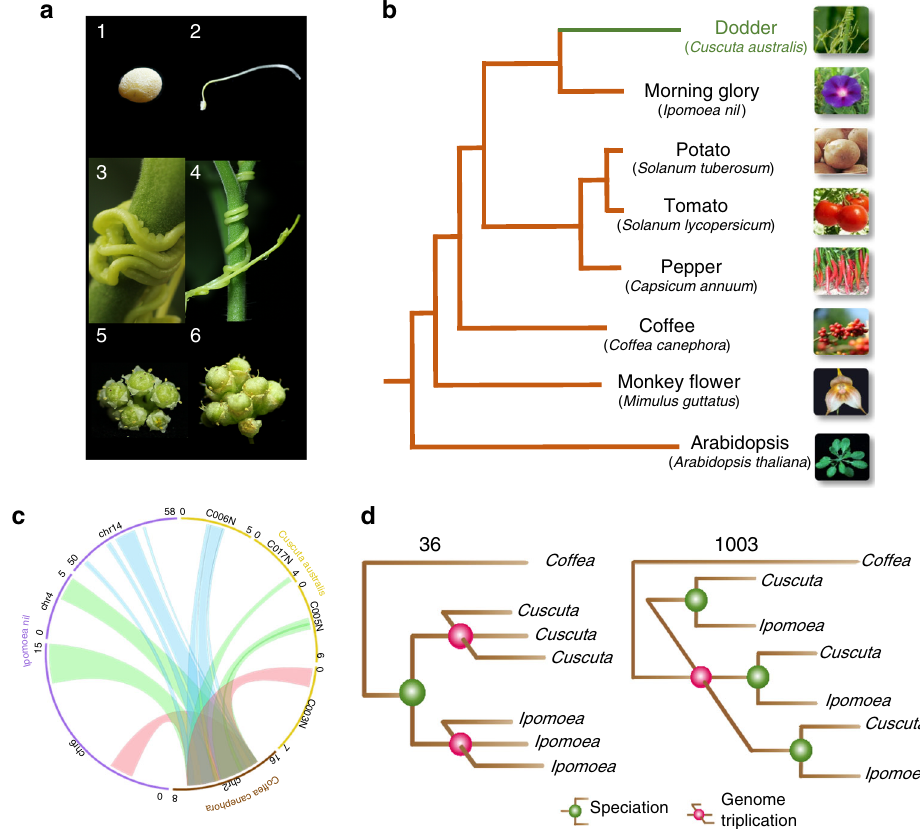
Fig. 1 Morphological traits and genome structure of C. australis . a Photographs of C. australis seed (1), seedling (2), vines twining around the wild tomato Solanum pennellii (3 & 4; partial haustoria can be seen in 3), fl owers (5), and seed capsules (6). b Phylogenetic tree generated from genome-wide one-to- one orthogroups (bootstrap values for all clades are 100%). c Circos plot of a set of syntenic genome segments of C. australis , Japanese morning glory, and coffee. Numbers besides terminals of each karyotype denote the start and end of chromosome segment or contigs with unit of Mb. d Numbers of gene clades (shown on top of the trees) supporting different hypotheses on the order of speciation and whole-genome triplication event in the Cuscuta and